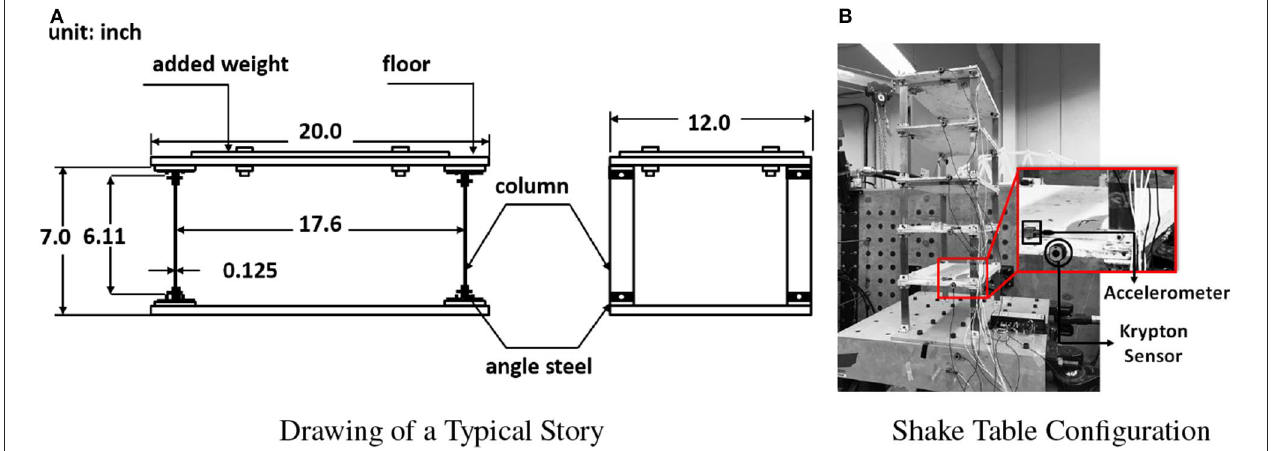
The shake table is driven by six hydraulic actuators: two in the x- axis, one in the y-axis, and three in the z-axis. All actuators